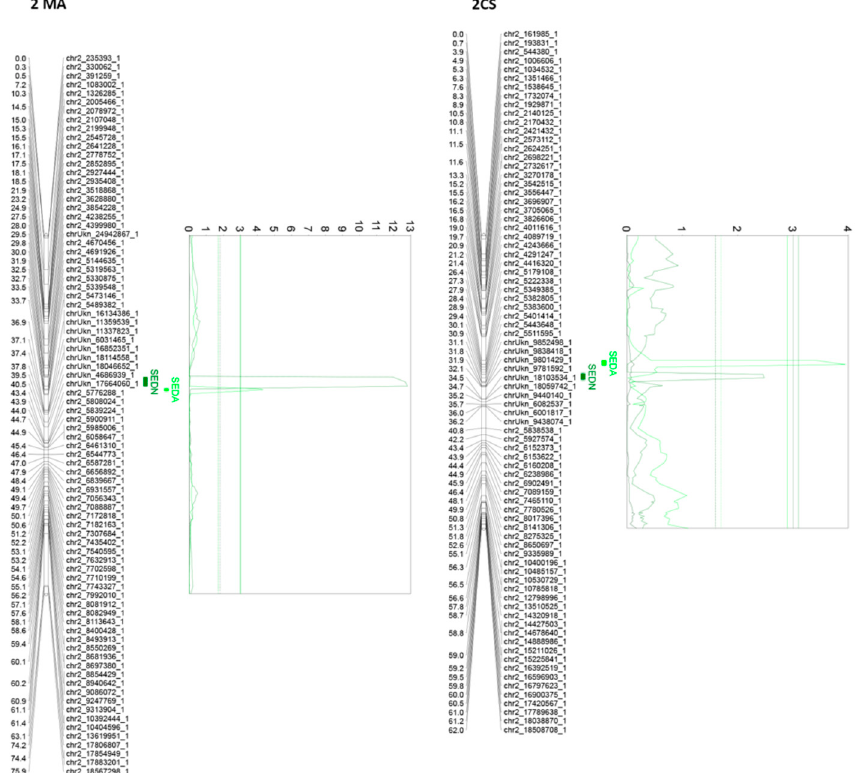
Figure 3. Principal QTLs detected in chromosome 2 for seedlessness subtraits SEDN and SEDA in the MA × CS experimental population. SEDN: number of seeds per berry; SEDA: average fresh weight of one seed. 1-LOD and 2-LOD support confidence intervals were drawn. Thresholds for suggestive (dashed lines) or significant (continues lines) QTLs were established by a permutation test with 10,000 iterations. Both parental maps were represented. MA: Muscat of Alexandria; CS: Crimson